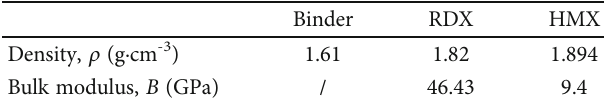
Table 5: Physical parameters of each